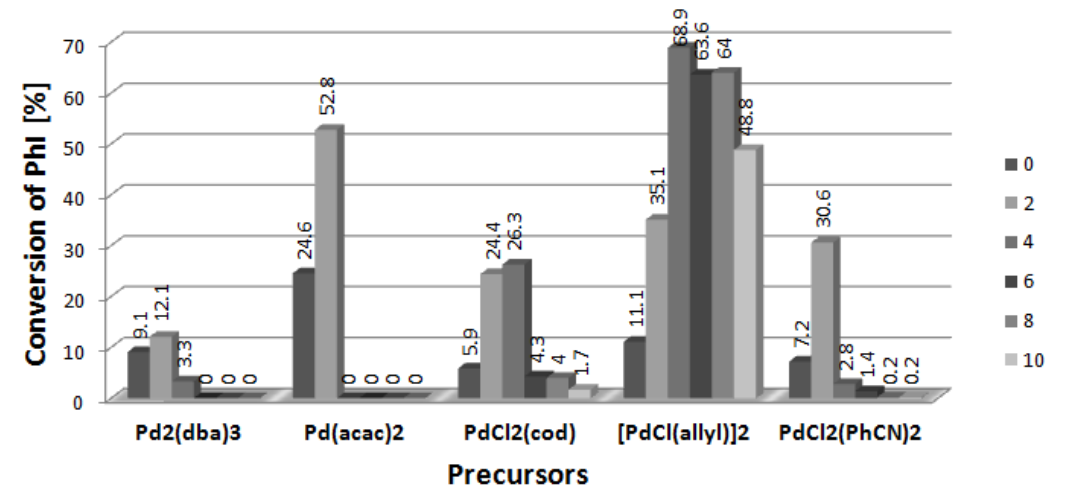
Figure 3. Effect of [CIL]:[Pd] ratio on conversion of PhI in Heck arylation of DHF. CIL =